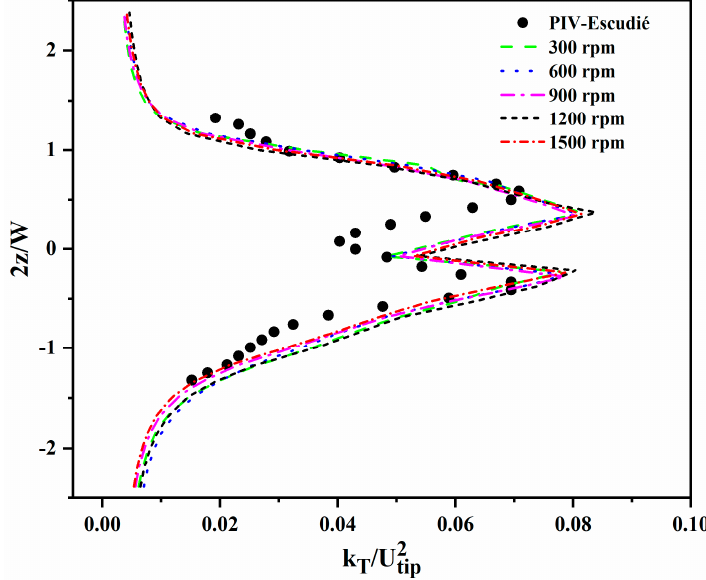
Figure 5. The turbulent kinetic energy normalized by U tip 2 .